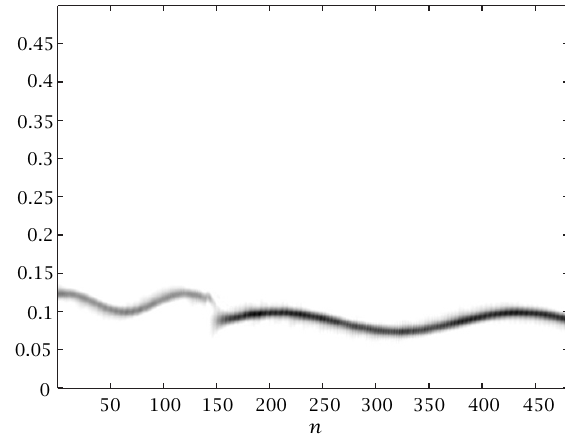
Figure 2: Estimated instantaneous spectrum of the density f(t) when a sequence t i of events is given. The number of events is twice the number of samples of the numerical version of f(t)